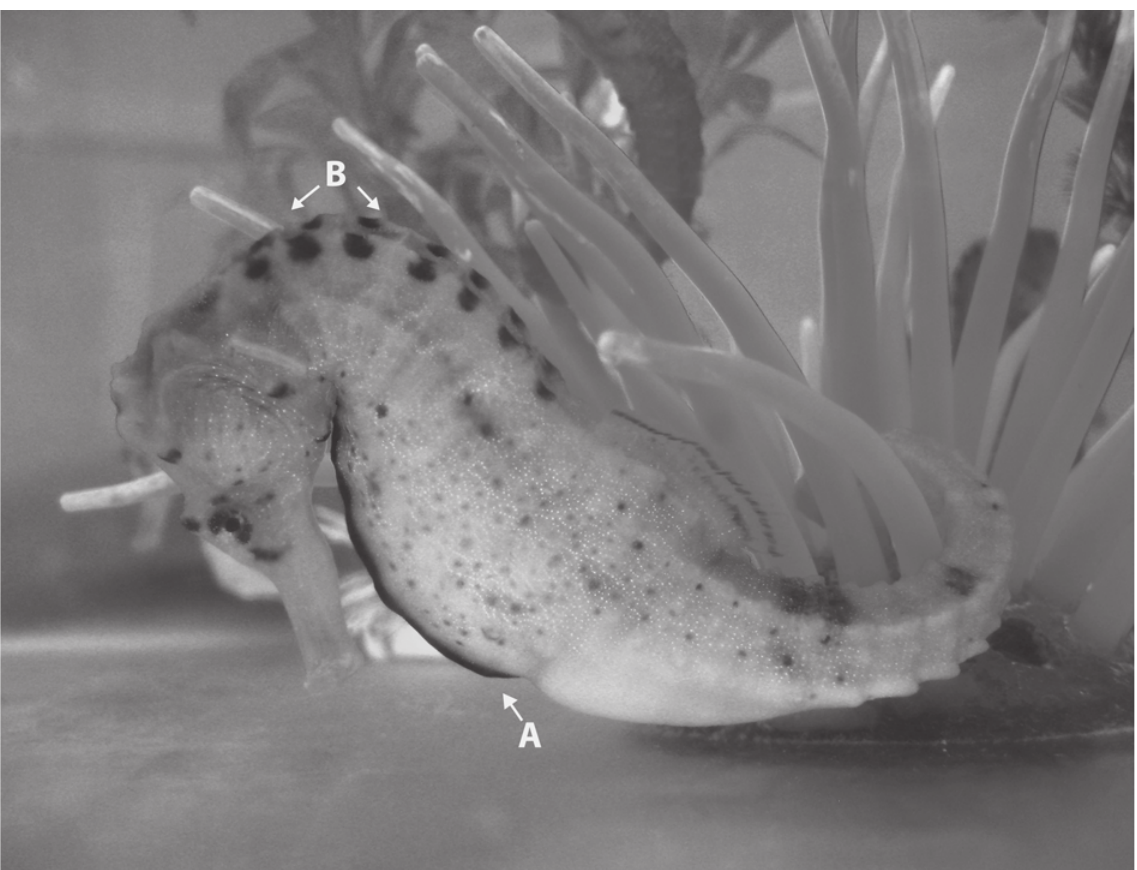
Fig. 1. A captive-reared male of Hippocampus reidi , showing (A) the prominent and pigmented keel and (B) dorsolateral spots. Photo credits: T. P. R. Oliveira.